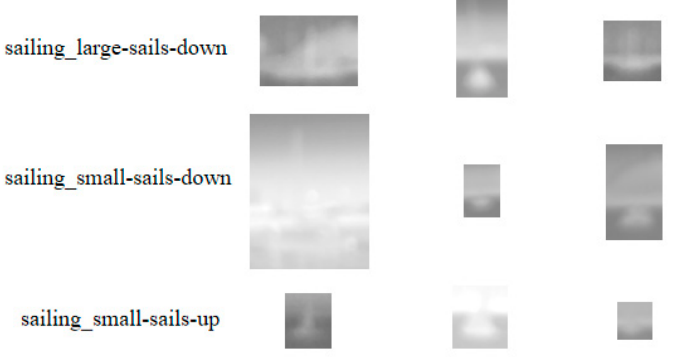
Figure 6. Fine-grained image examples under the sailing class.